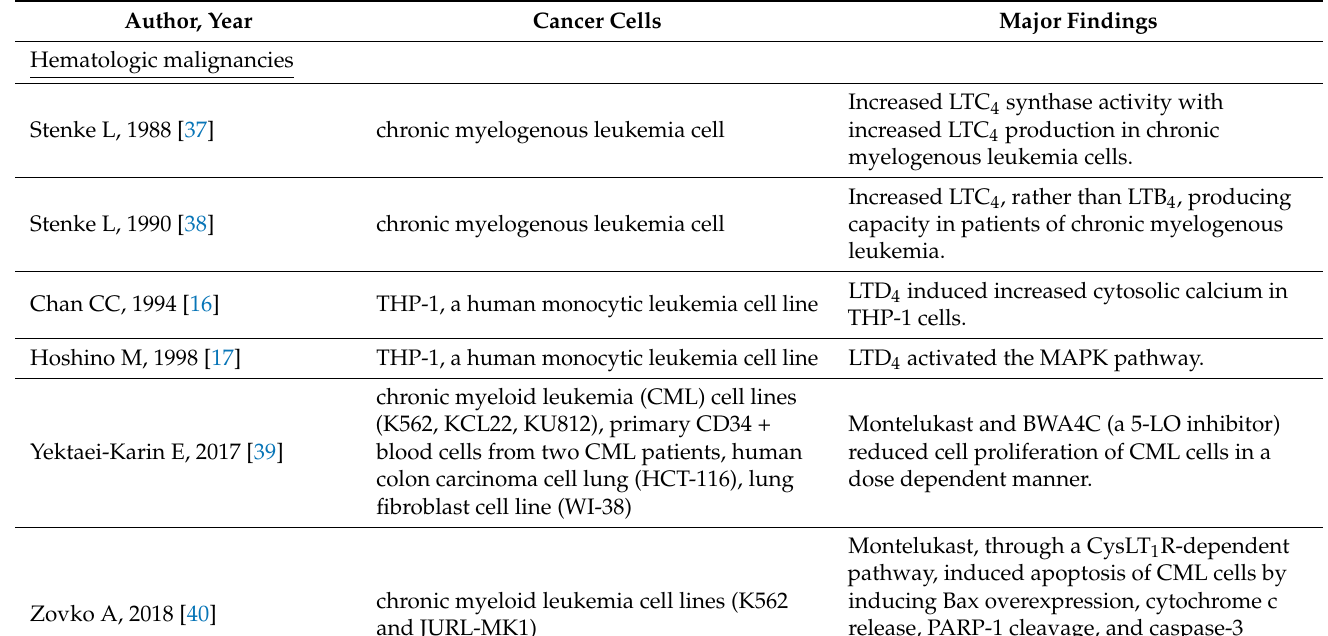
Table A1. Selected in vitro studies investigating the cysteinyl leukotriene pathway in